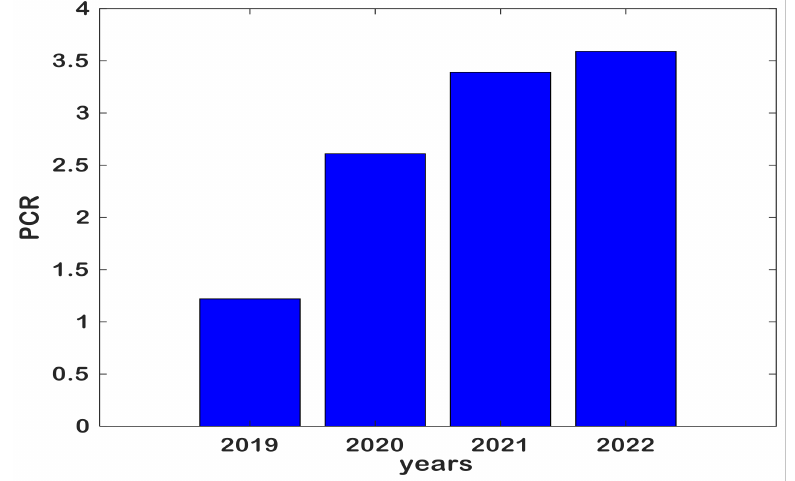
Figure 6. Improvement of PCR.